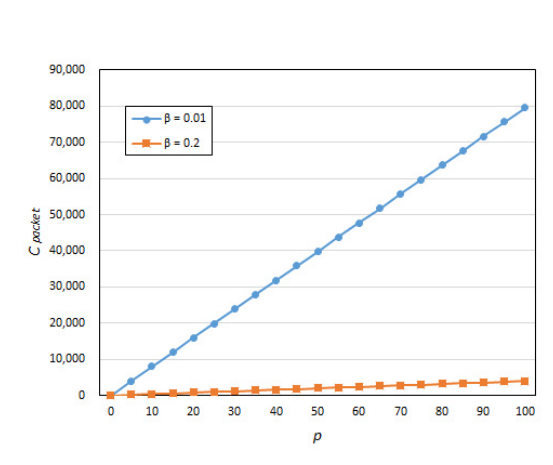
Figure 7. Packet data transmission overhead ( (cid:22) = 0 : 1 ). average overhead for signaling can be expressed as / T a by anal yzing the C signal (cid:0) a = C signal (cid:0) proposed